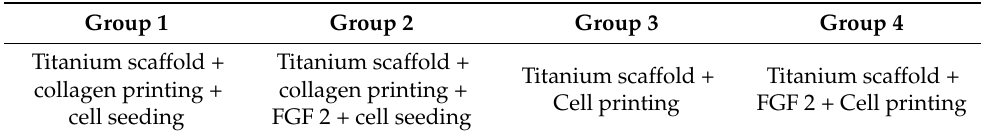
Table 1. Description of each